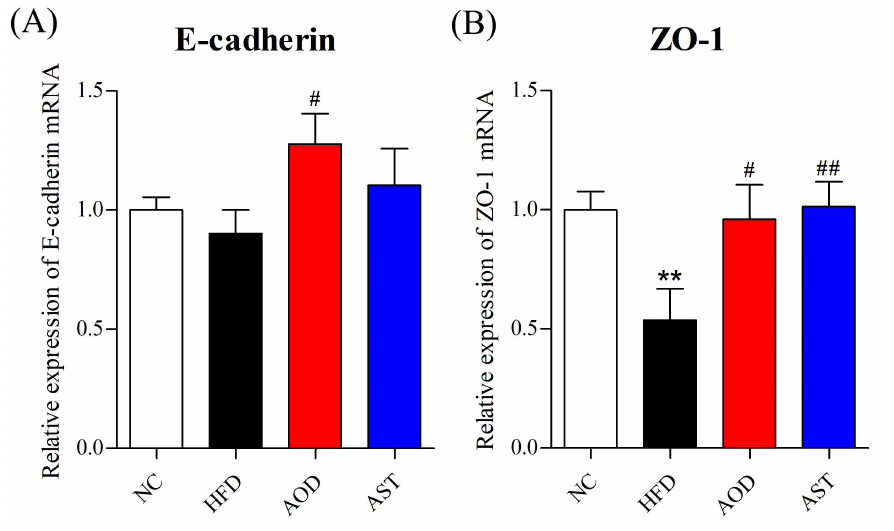
Figure 4. AOD upregulated the expression levels of tight junction components in the jejunum. mRNA expression levels of ( A ) E-cadherin and ( B ) zonula occludens 1 (ZO-1) in the jejunal tissue. NC: normal control diet; HFD: high-fat and high-sucrose diet; AOD: high-fat and high-sucrose diet supplemented with astaxanthin n -octanoic acid diester (50 mg / kg body weight) for 8 weeks; AST: high-fat and high-sucrose diet supplemented with free astaxanthin (50 mg / kg body weight) for 8 weeks. The values are presented as mean ± SEM, n = 10. ** p < 0.01 vs. NC, and # p < 0.05, ## p < 0.01 vs. HFD